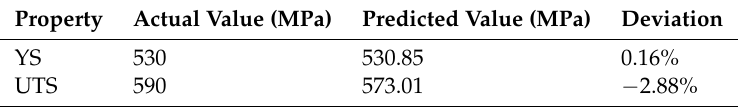
Table 5. Predicted values of the YS and UTS for Al 7010 using the empirical